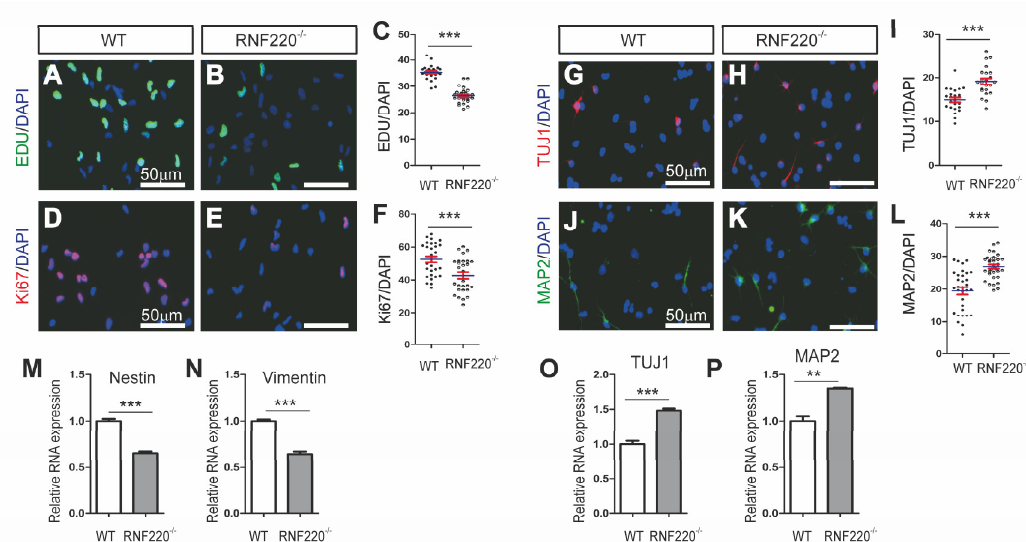
Figure 2. Loss of RNF220 inhibited NSC proliferation and promoted differentiation of NSCs. ( A – F ) Loss of RNF220 inhibited NSCs proliferation by EDU incorporation assay ( A – C ) and Ki67 immunostaining ( D – F ); the nuclei were marked by DAPI. Scale bar: 50 μm. ( C , F ) The quantification data for ( A , B ) and ( D , E ) respectively. ( G – L ) Immunofluorescence analyses of the differentiated neurons from WT and ZC4H2 −/− NSCs for β-tubulin III (TUJ1) ( G – I ) and MAP2 ( J – L ); the nuclei were marked by DAPI. Scale bar: 50 μm. ( I , L ) The quantification data for ( G , H ) and ( J , K ), respectively. ( M , N ) Expression of stemness marker genes (Nestin and Vimentin) in WT and RNF220 −/− NSCs. ( O , P ) Expression of neuronal marker genes (TUJ1 and MAP2) in differentiated WT and RNF220 -/- NSCs. β-actin was used as an internal control. * p < 0.05, ** p < 0.01, *** p < 0.001, two-tailed Student’s t -test. Data represent mean ± SD from three independent biological replicates.